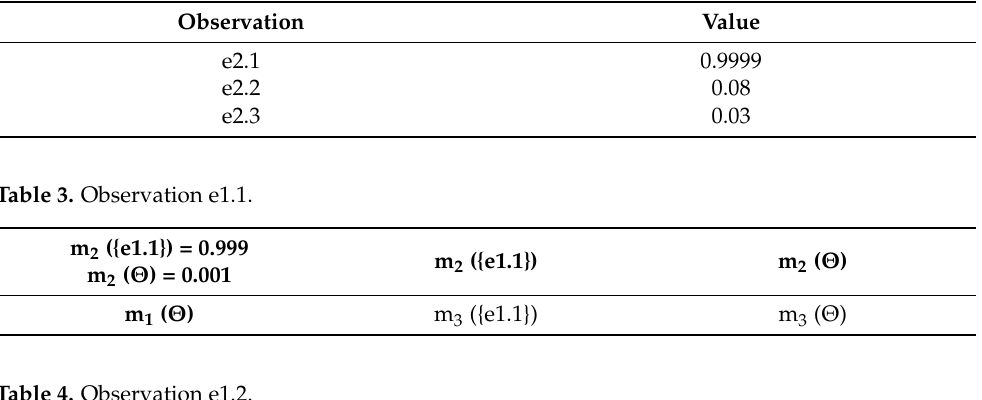
Table 4. Observation